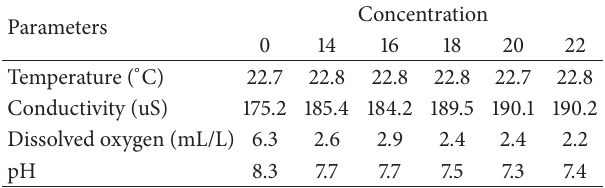
Table 1: Physical-chemical parameters of water.